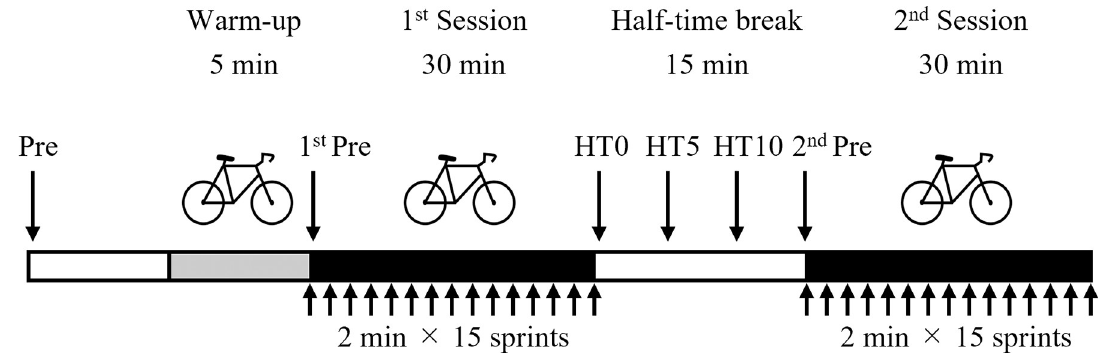
Fig 1. Experimental protocol. HT0: start of the half-time break; HT5: 5 min after HT0; HT10: 10 min after HT0. Each 30-min session consisted of 15 sprints (i.e., maximal pedaling), each lasting 6 sec, interspersed by 114 sec of low work rate pedaling. The two 30-min sessions were separated by a 15-min break at half-time. Participants ingested 150 g of − 2˚C-ice slurry, or a 30˚C-beverage, or 30˚C-water every 5 min (total 450 g) during the 15-min half-time break.